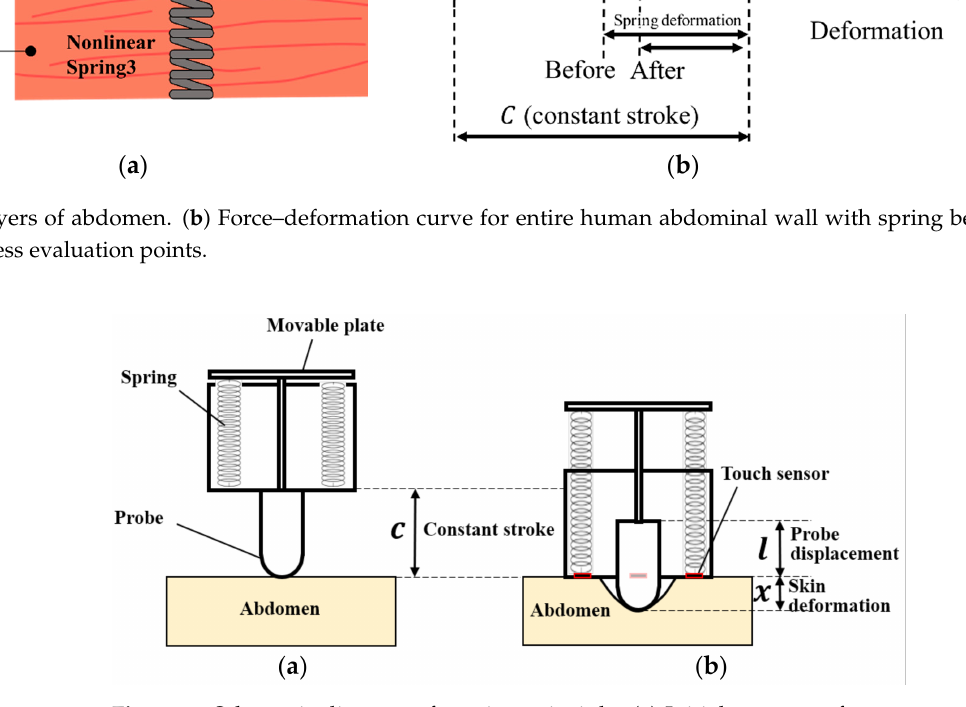
Figure 2. Schematic diagram of sensing principle: ( a ) Initial moment of measurement. ( b ) Final moment of